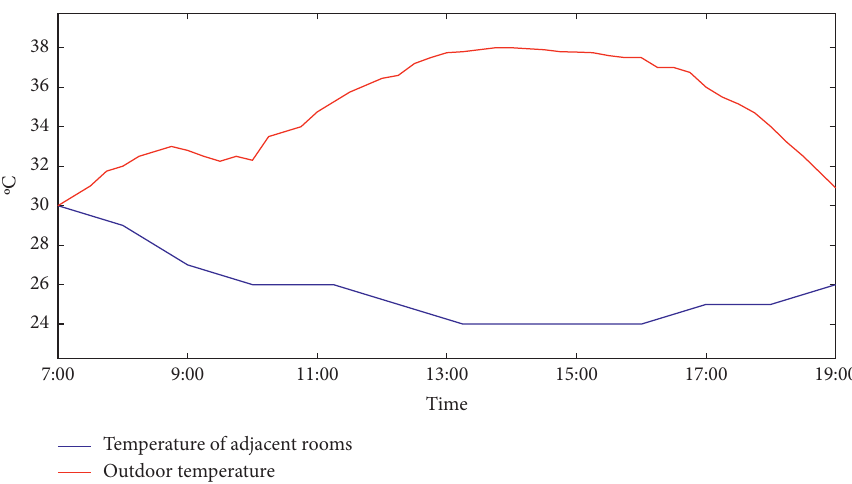
Figure 9: Outdoor temperature and temperature change of the next room.